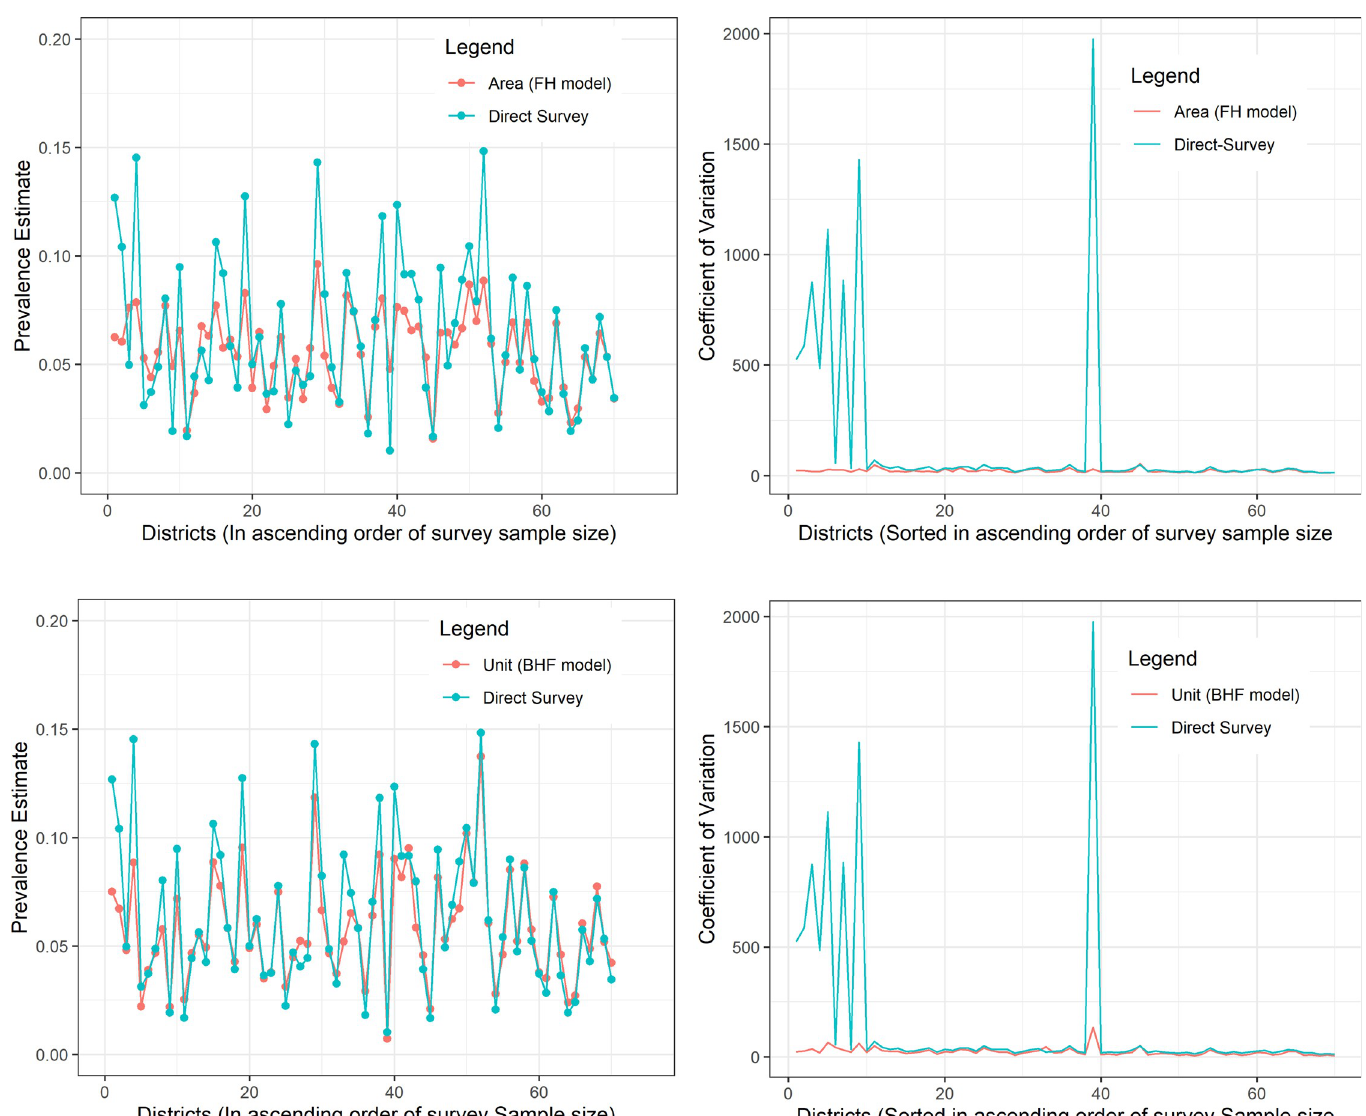
Fig 3. HIV prevalence estimates and the coefficient of variation of direct survey and model-based estimates in Uganda. HIV prevalence estimates (on the left) and the coefficient of variation (on the right) for direct survey and model-based estimates with the districts sorted in ascending order of the survey sample sizes. (a) direct survey compared to area-level model estimates using the Fay-Herriot (FH) model, (b) coefficient of variation for direct survey and area-level model estimates, (c) direct survey compared to unit-level model estimates using the Battese-Harter-Fuller (BHF) model, and (d) coefficient of variation for direct survey and unit-level model estimates.